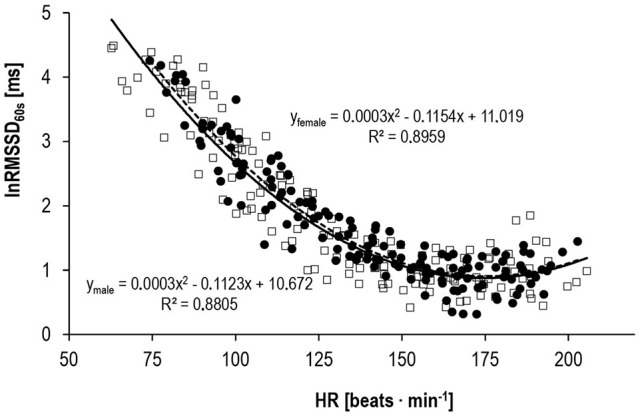
Correlation between lnRMSSD60s and HR for male (□, solid line, n = 10) and female subjects (•, dashed line, n = 10) during progressive exercise.